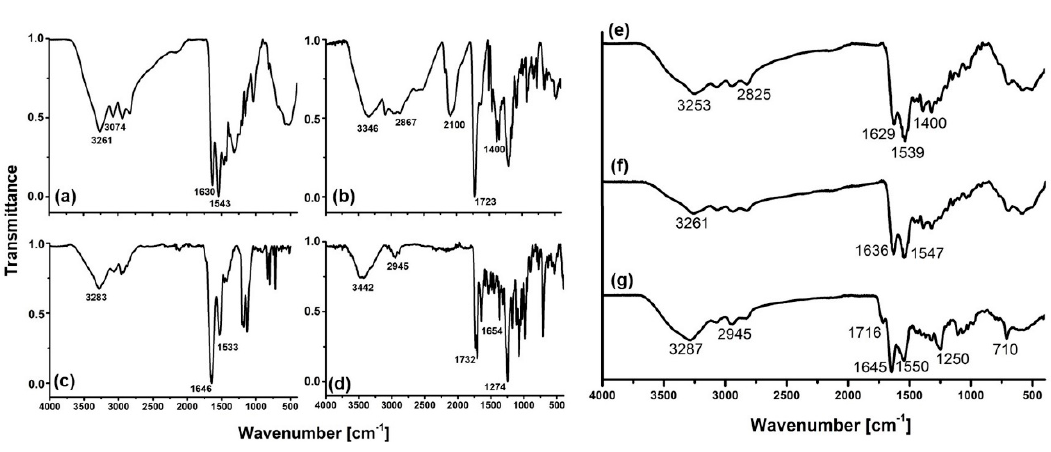
Figure 3. The FT-IR spectrum of ( a ) PAMAM Dendrimer (DN), ( b ) pSCN-Bn-DOTA (DOTA), ( c ) Lys 1 Lys 3 (DOTA)-BN (BN), ( d ) Paclitaxel (PTX), ( e ) DOTA-DN, ( f ) DOTA-DN-BN, ( g ) DOTA- DN(PTX)-BN.